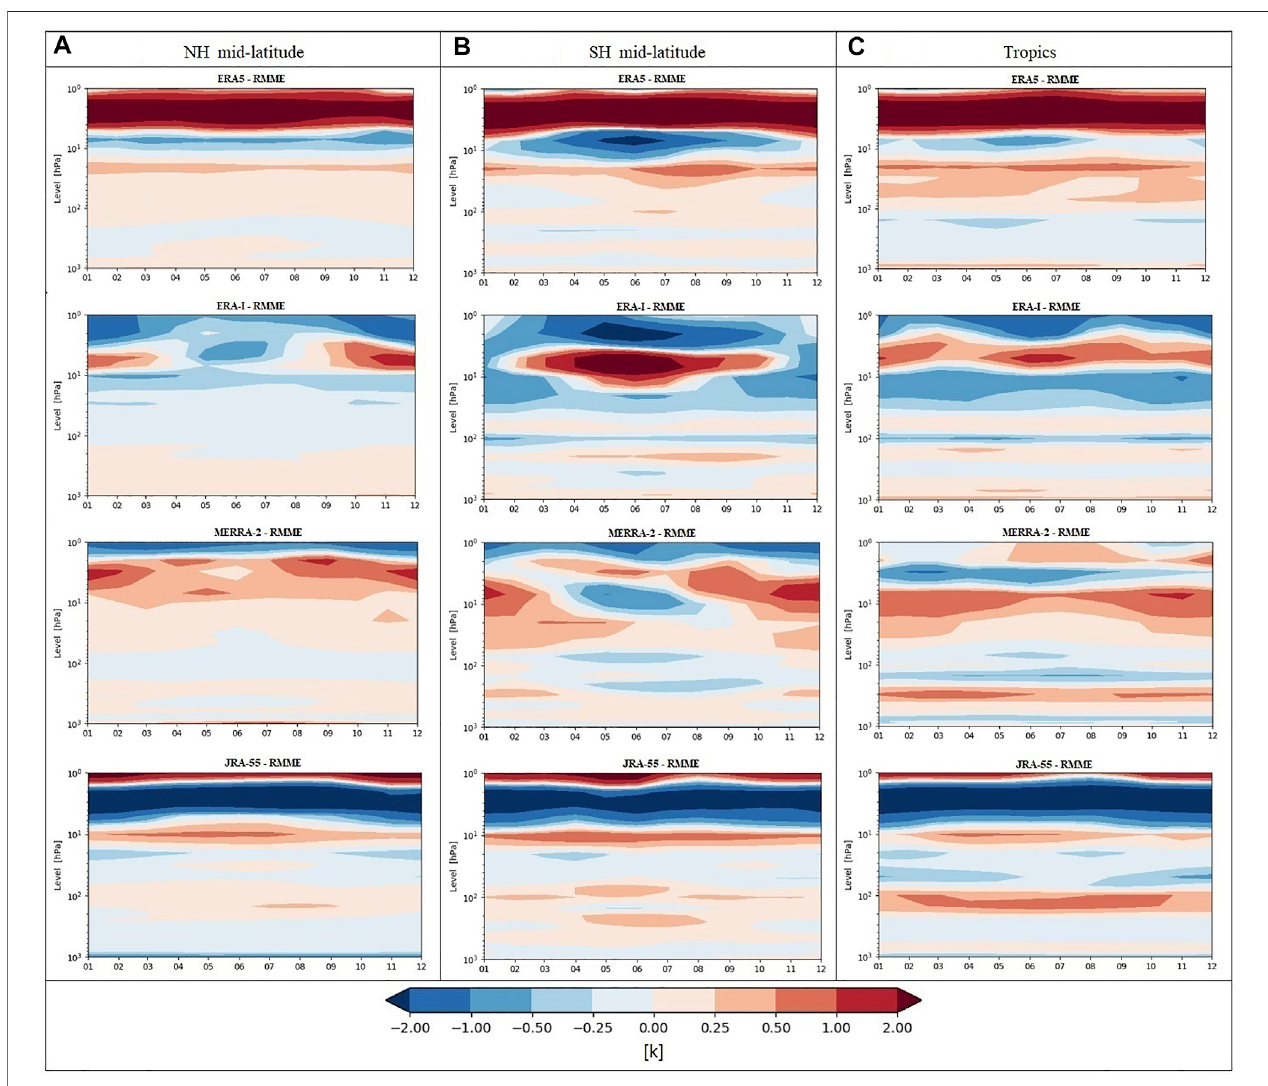
FIGURE 3 | Seasonal cycle difference (month vs. pressure level) differences (in K) between reanalyses and RMME in the ( A- column) NH mid-latitude, ( B- column) SH mid-latitude, and ( C- column) tropics, spanning the period 1980 – 2000.